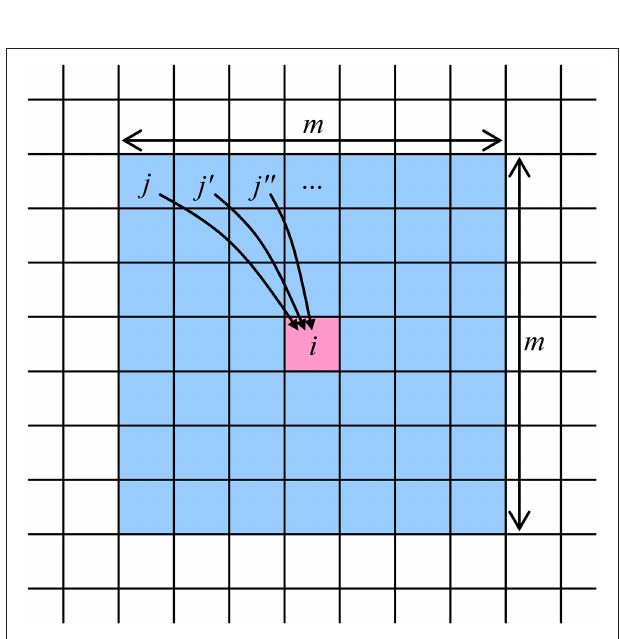
FIGURE 2 | The connectivity domain of a neuron cell number i , which may be provided by a memristive CrossNet with the InBar topology (Türel et al., 2004). Note that each cell has a similar domain, so that the connection between the cells of each pair is two-sided—though typically